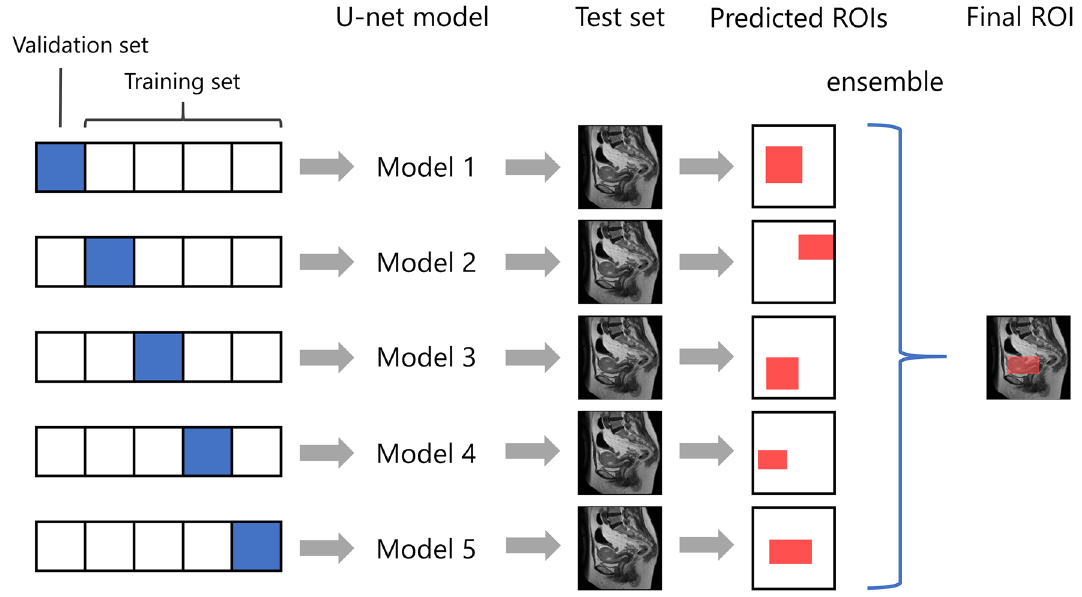
Figure 4. Overall workflow for predicting the area of endometrial cancer. ROI : region of